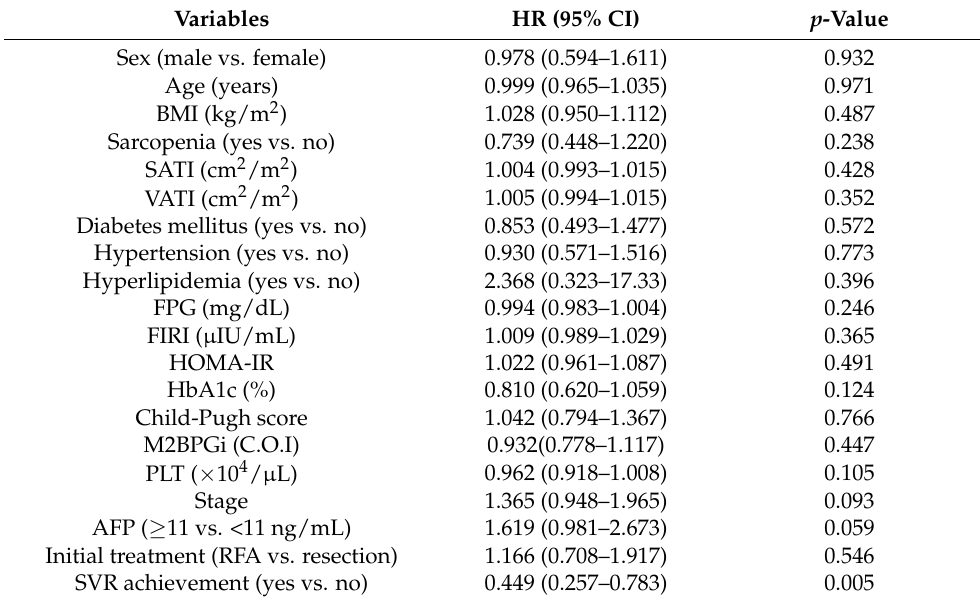
0.449, 95% confidence interval: 0.257–0.783; p = 0.005) (Table 3). Table 3. Analysis of the possible risk factors for hepatocellular carcinoma recurrence using the Cox proportional hazards